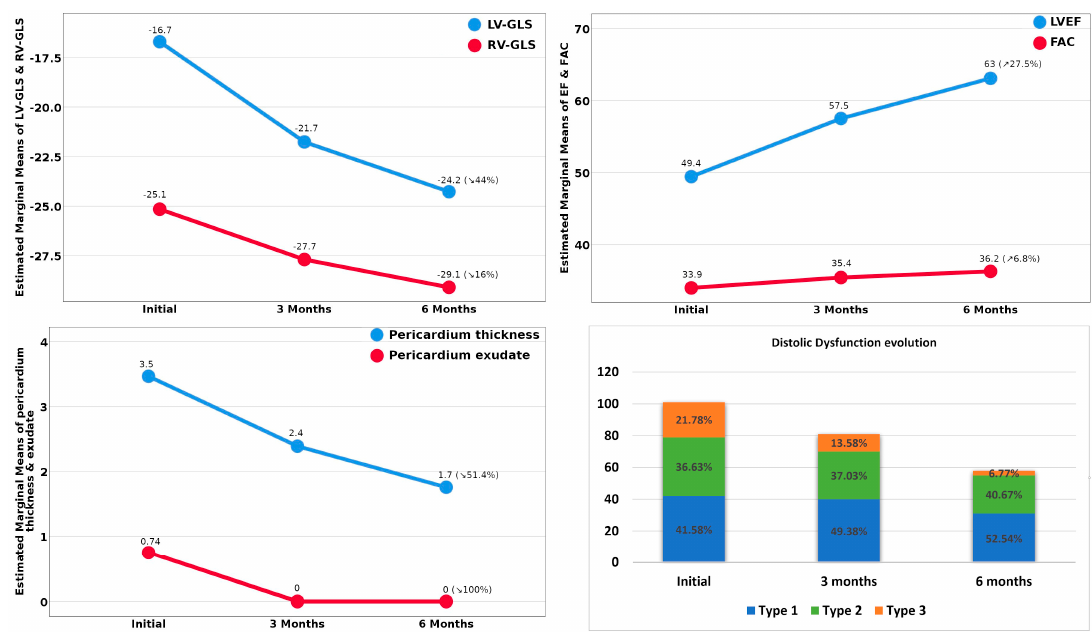
Figure 2. Evolution of the TTE-assessed abnormalities identified in study